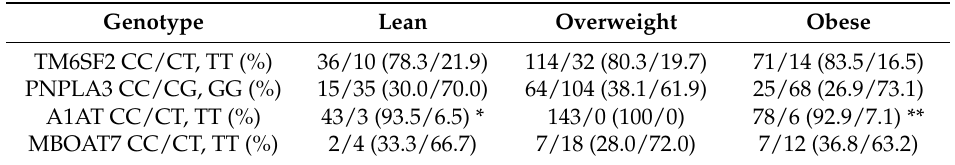
Table 2. Carrier rates of genes determined; where available from previous data collections, genotypes of determined alleles are reported. Due to the retrospective nature of the study only incomplete sets were available, carriers of at least one risk allele were counted as one